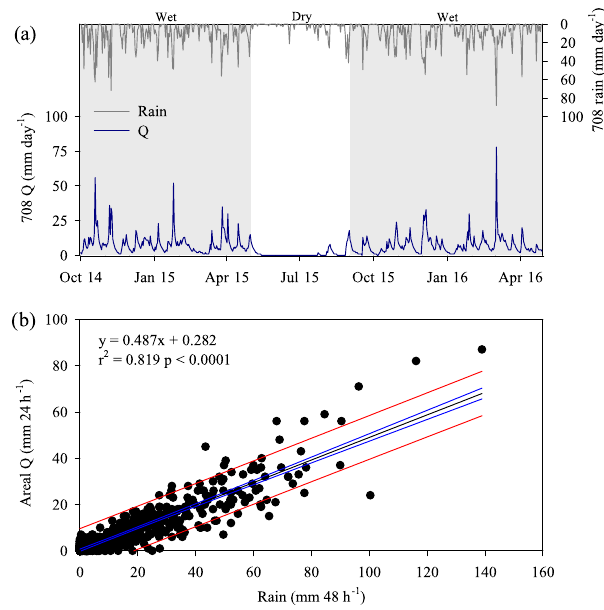
Figure 2. Hydrological patterns typical of watersheds located in the study area. (a) The hydrograph and precipitation record from Wa- tershed 708 for the study period of 1 October 2015–30 April 2016. Grey shading indicates the wet period (1 September–30 April) and the unshaded region indicates the dry period (1 May–30 August). (b) Correlation of daily (24h) areal runoff (discharge of all water- sheds combined) to 48h total rainfall recorded at watershed 708. For the period of study, comparisons of daily runoff to 48h rainfall (runoff:rainfall mean: 0.92; SD ± 0.27) indicated rapid discharge response to